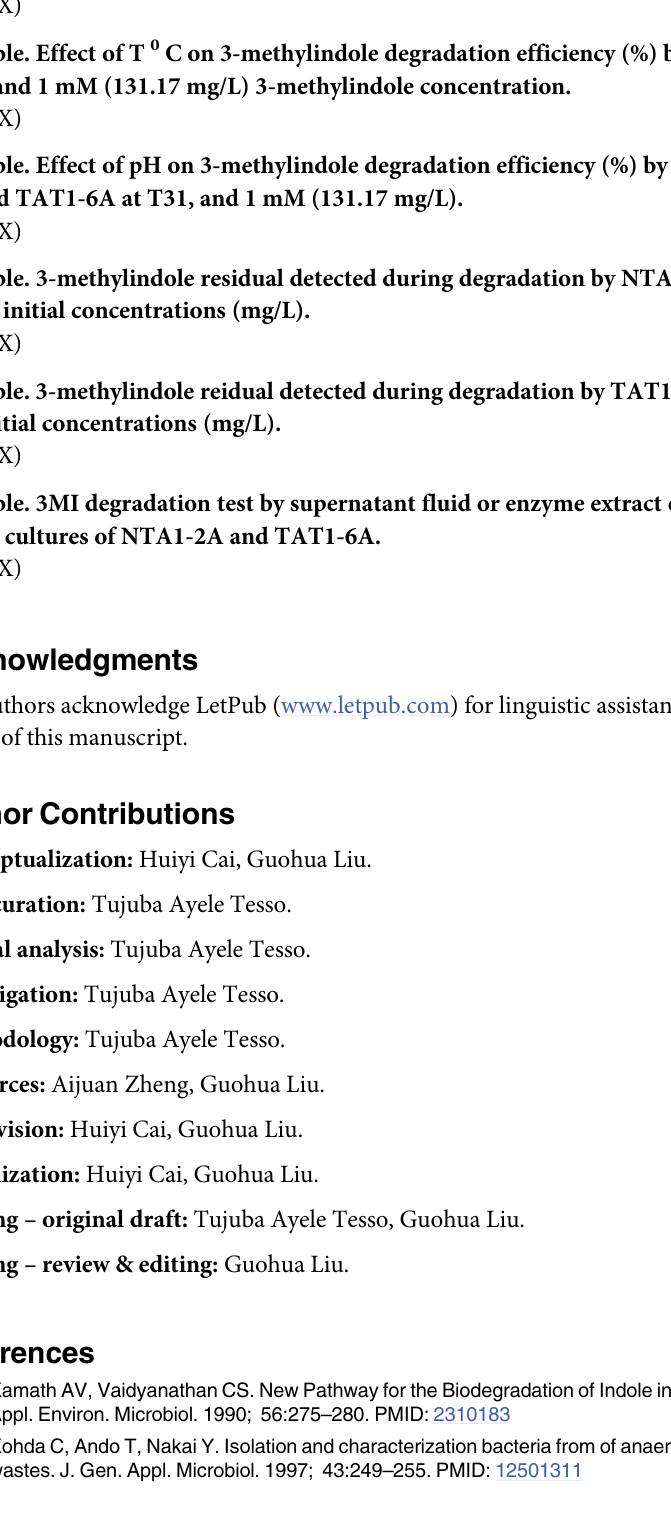
S3 Table. Proliferation of the strains under different pH; ( A) Acinetobacter toweneri